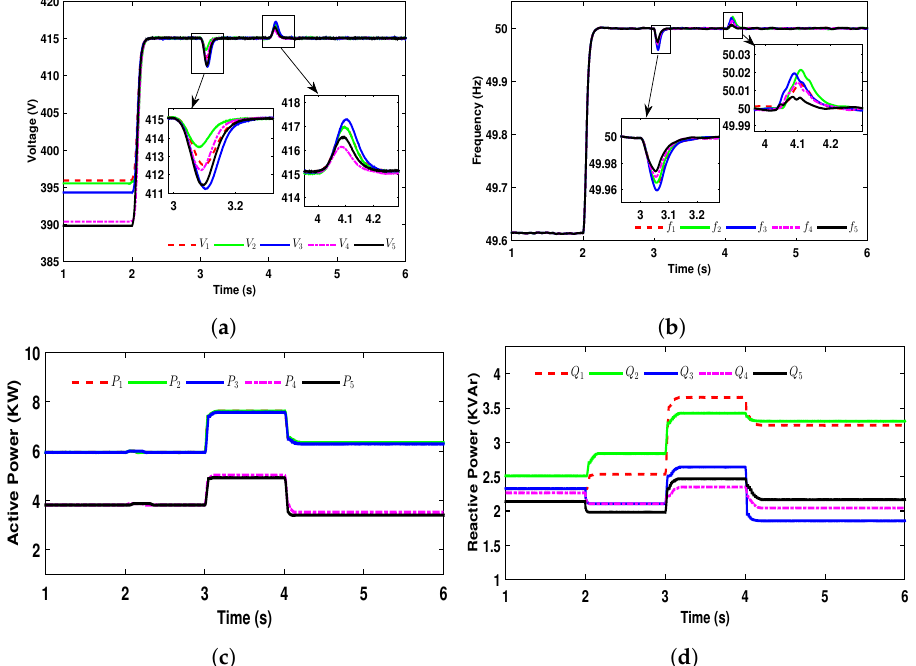
Figure 5. Performance analysis of proposed controller. ( a ) Voltage. ( b ) Frequency. ( c ) Active power. ( d ) Reactive